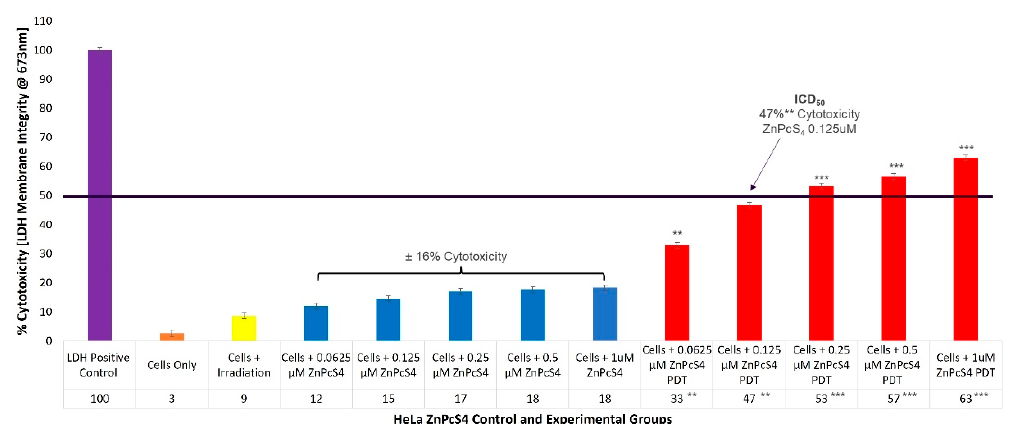
Figure 1. LDH membrane integrity response of HeLa cells treated with varying increasing concentra- tions of ZnPcS 4 PS, demonstrating a significant dose-dependent increase in cellular cytotoxicity post PDT ( p < 0.01** or p < 0.001***).